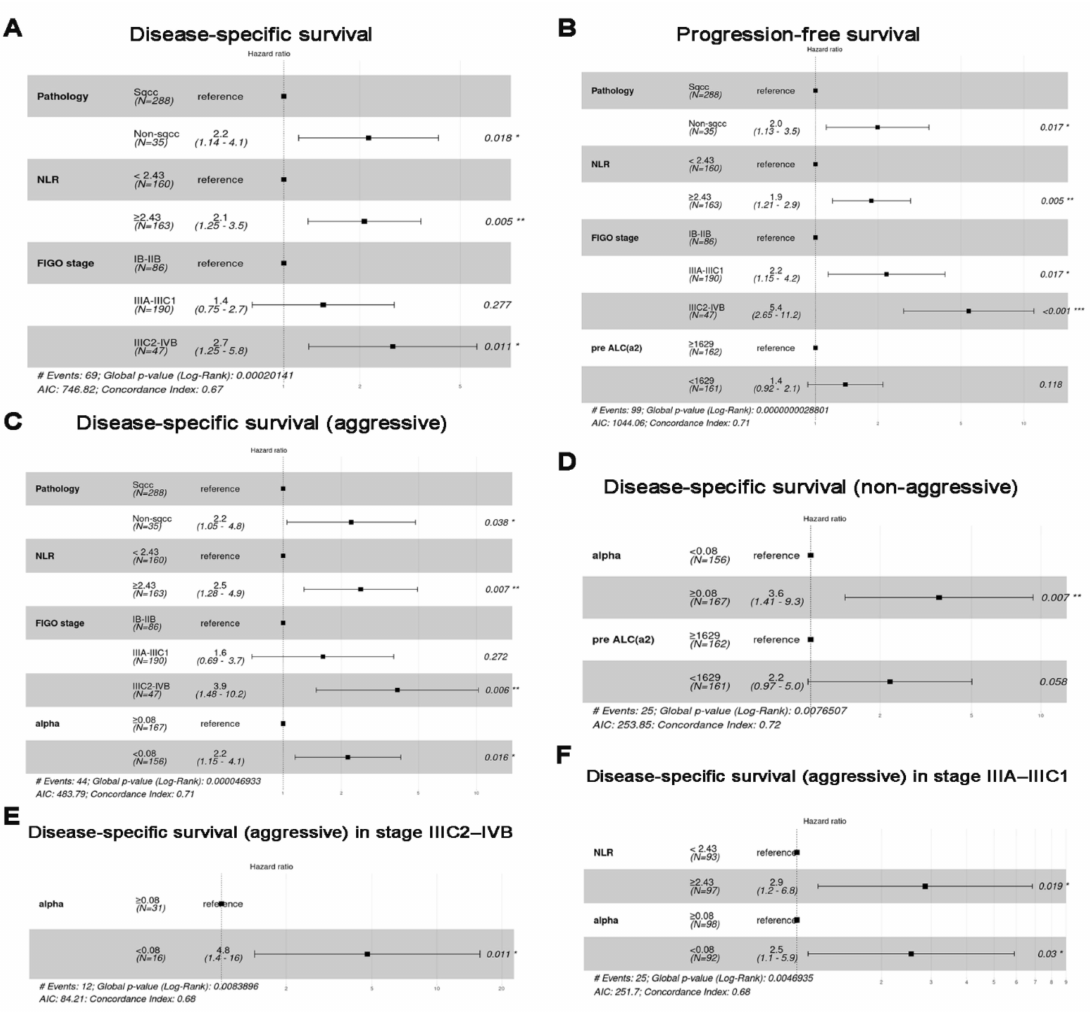
Figure 4. Multivariate analysis using the Cox regression model of ( A ) disease-specific survival (DSS), ( B ) progression-free survival, ( C ) DSS (aggressive group), ( D ) DSS (non-aggressive group), ( E ) DSS (aggressive group) in stage IIIC2–IVB, and ( F ) DSS (aggressive group) in stage IIIA–IIIC1. NLR—neutrophil-to-lymphocyte ratio; Sqcc—squamous cell carcinoma; FIGO—International Fed- eration of Gynecology and Obstetrics; AIC—Akaike information criterion.; * p < 0.05, ** p <